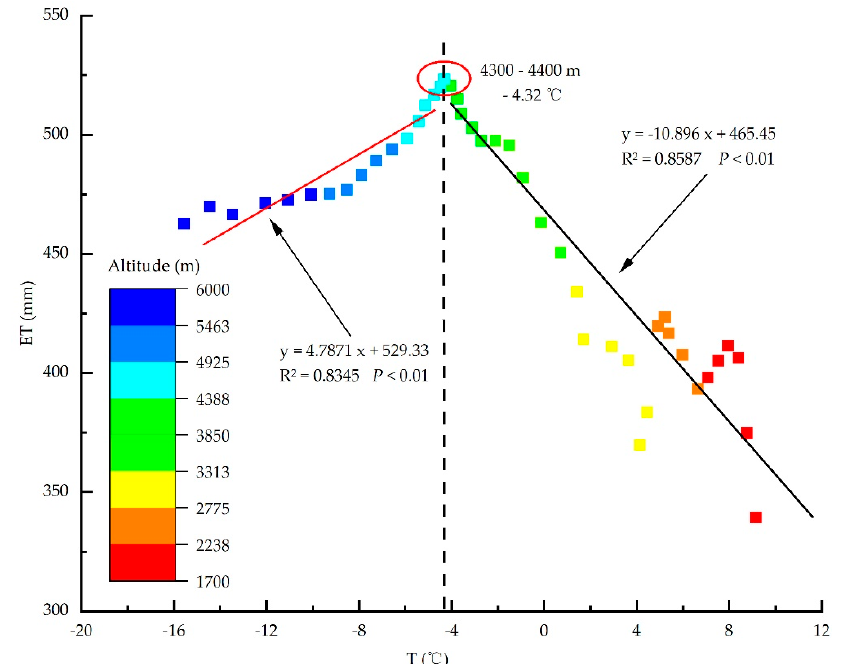
Figure 9. Correlation between T and ET on the altitude gradient.